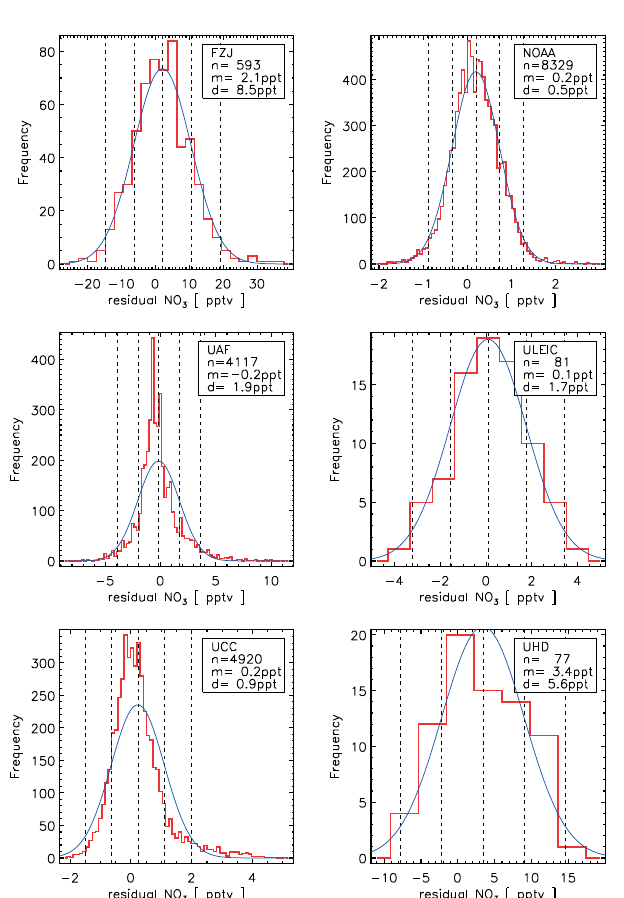
Fig. 2. Frequency distribution of zero-NO 3 mixing ratio measure- ments. A normal distribution (blue line) was fitted to the histograms. The histogram of the MPI-CRDS instrument is not shown because the number of available data points ( n ) was too small to be statisti- cally meaningful. The 1 σ standard deviation, d , is a measure for the instrumental precision during NO3Comp; m denotes the mean NO 3 mixing